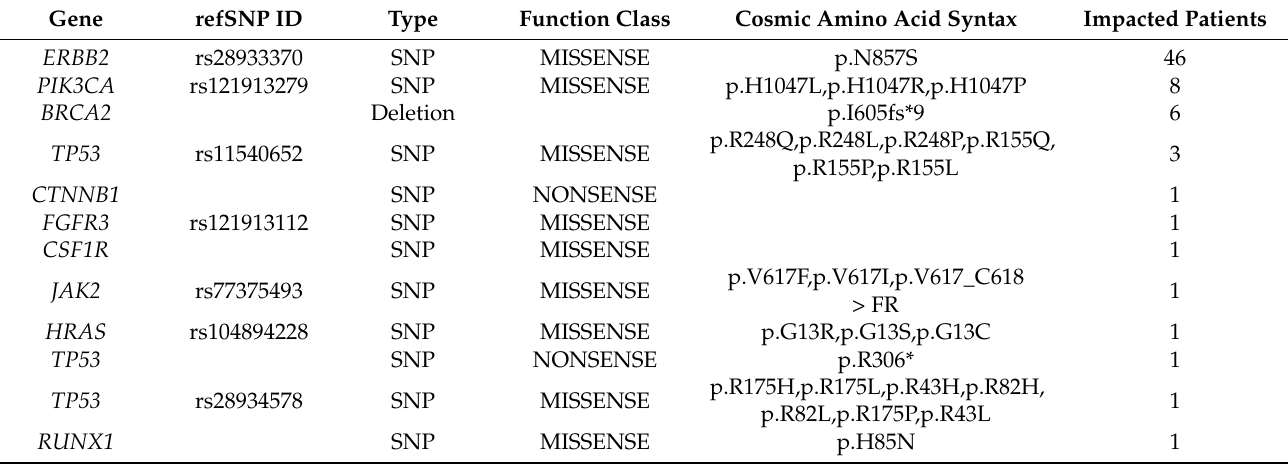
Table 2. Pathogenic variants identified by dbSNP